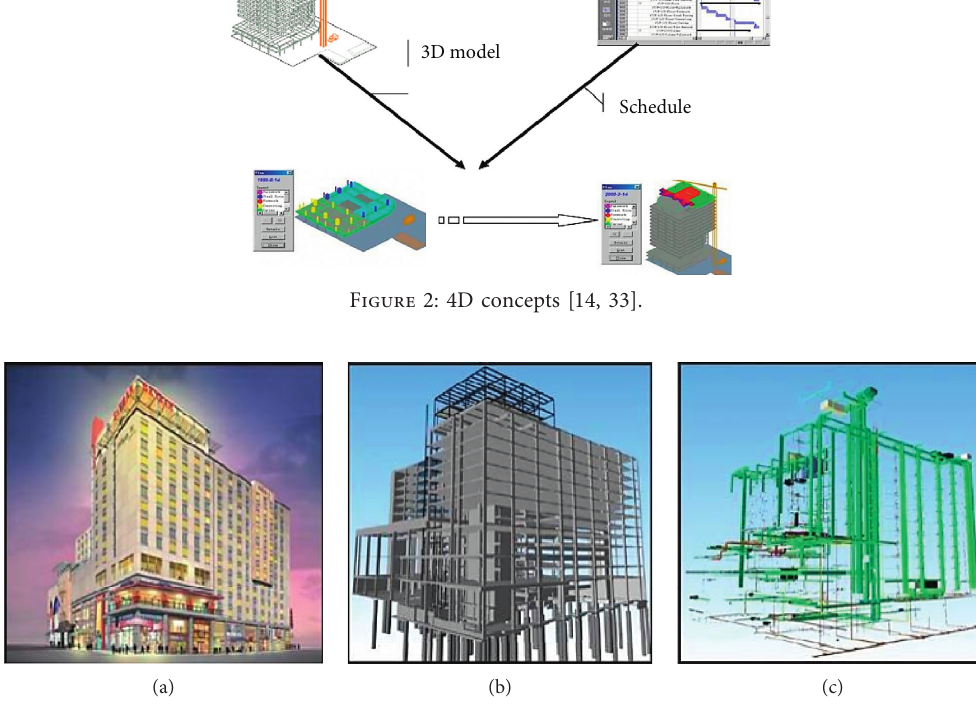
Figure 3: 3D models of BIM [14]. (a) Architectural model. (b) Structural model. (c) Plumbing.